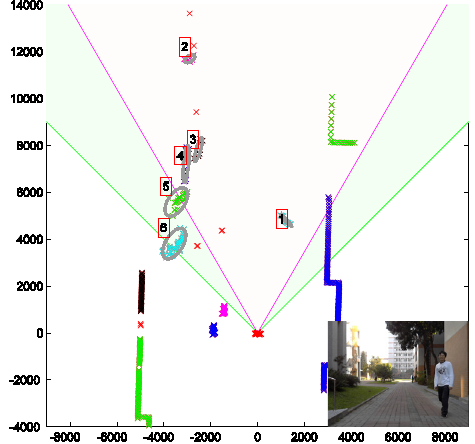
Fig. 2. Points are clustered into several clusters marked in different colors by DBSCAN. The noise points are marked in red.